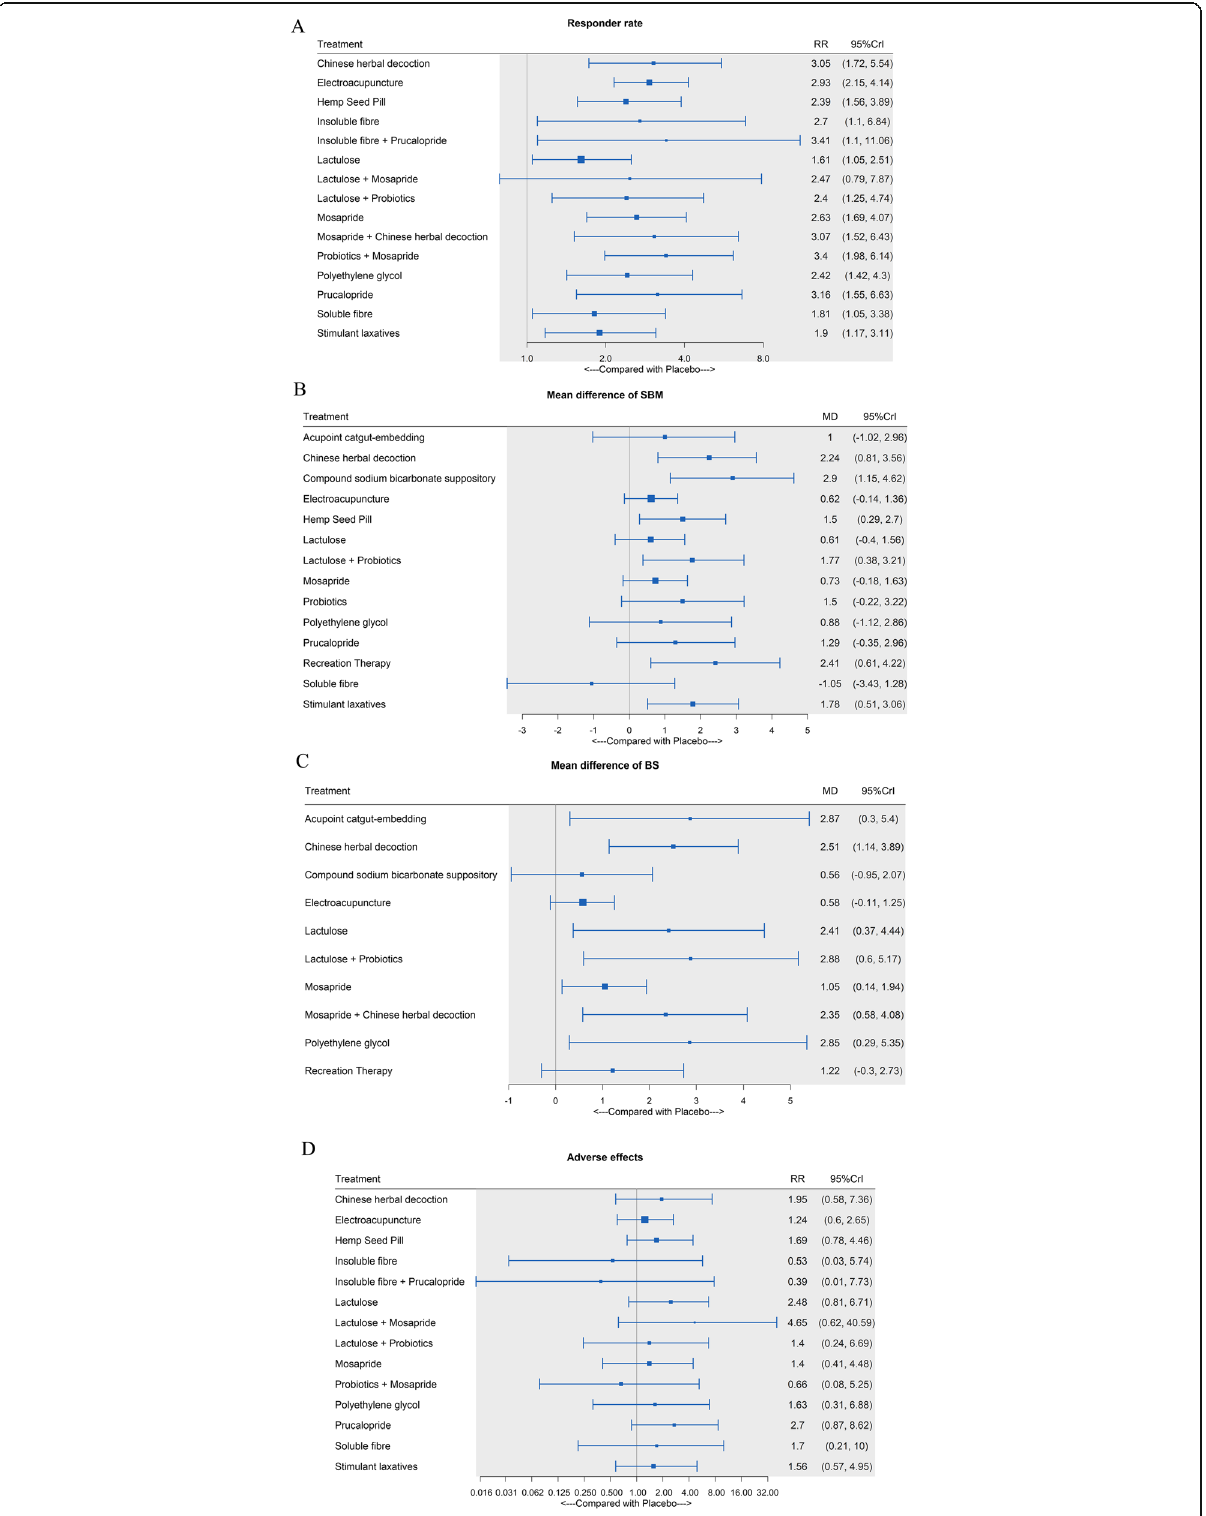
Fig. 4 Forest plot. a The risk ratio of the responder rate. b The mean difference of the SBM count. c : The mean difference of the BS. d : The risk ratio of adverse